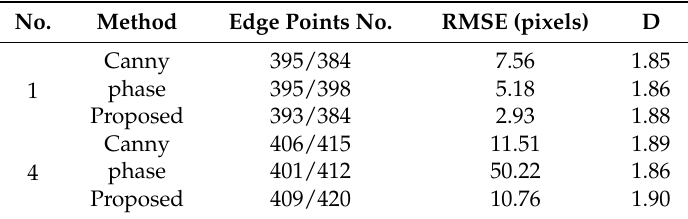
Table 2. Experimental results of features-based preregistration. RMSE: root mean square error; D: Gaussian weighted distance-based similarity metric.